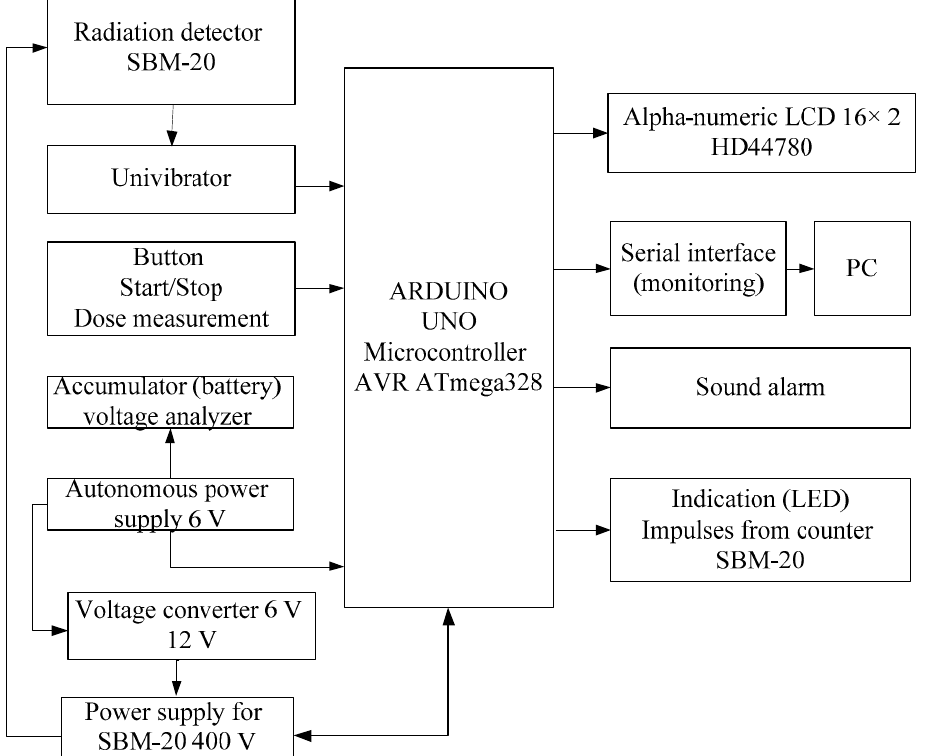
Figure 1. The block diagram of the microcontroller-based radiation monitoring built on the Arduino Uno board [15].